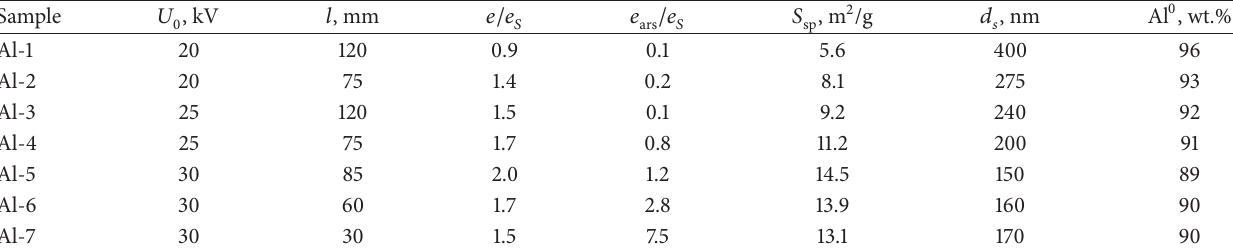
Table 1: Impact of EEW energetic parameters on the characteristics of Al